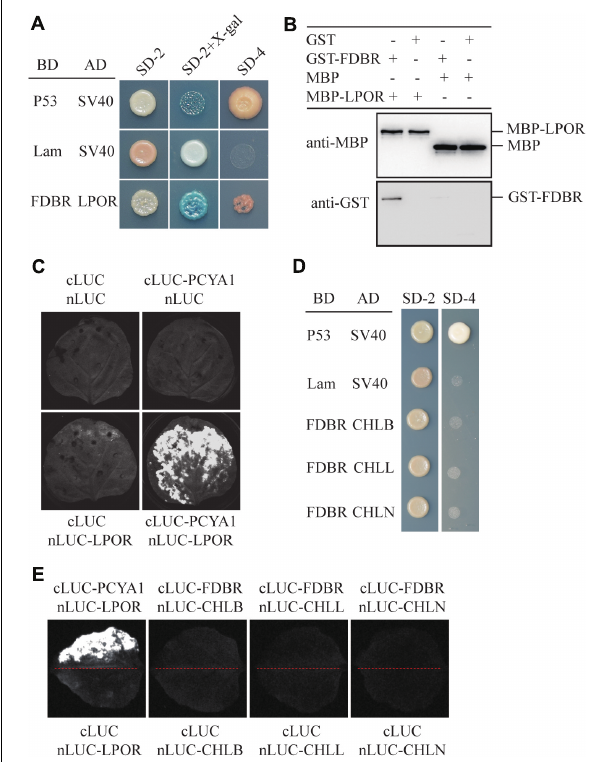
FIGURE 2 | CrPCYA1 FDBR domain interacts with LPOR, but not with DPOR in vitro and in planta . (A) Yeast two-hybrid assay of the interaction between FDBR and LPOR. P53 and SV40 were used as a pair of positive control. Lam and SV40 were used as a negative control. SD-2, SD-Trp-Leu; SD-2+X-gal, SD-Trp-Leu medium supplemented with X- β -gal (80 µ g/ml); SD-4, SD-Trp-Leu-His-Ade. (B) Pull-down assay for the interaction of FDBR with LPOR in vitro . MBP-fusion protein and GST-fusion protein were co-incubated with MBP resin. After washing, proteins captured by MBP resin were analyzed. Antibodies against GST-tag and MBP-tag were used for immunoblotting analysis. (C) Split-luciferase assay by co-expression of cLUC-PCYA1 and nLUC-LPOR in tobacco leaves. cLUC and nLUC were used as a negative control. Images were taken at 48 h after infiltration. The strong luminescence signal indicates interaction between PCYA1 and LPOR in planta . (D) Yeast two-hybrid assay of the interaction between FDBR and three subunits of DPOR: CHLB, CHLL and CHLN. (E) Split-luciferase assay for the interaction of FDBR with CHLB, CHLL and CHLN. Co-expression of cLUC and nLUC, cLUC-FDBR and nLUC, cLUC and nLUC-CHLB/L/N in tobacco leaves were used as negative controls. Co-expression of cLUC-PCYA1 and nLUC-LPOR was used as a positive